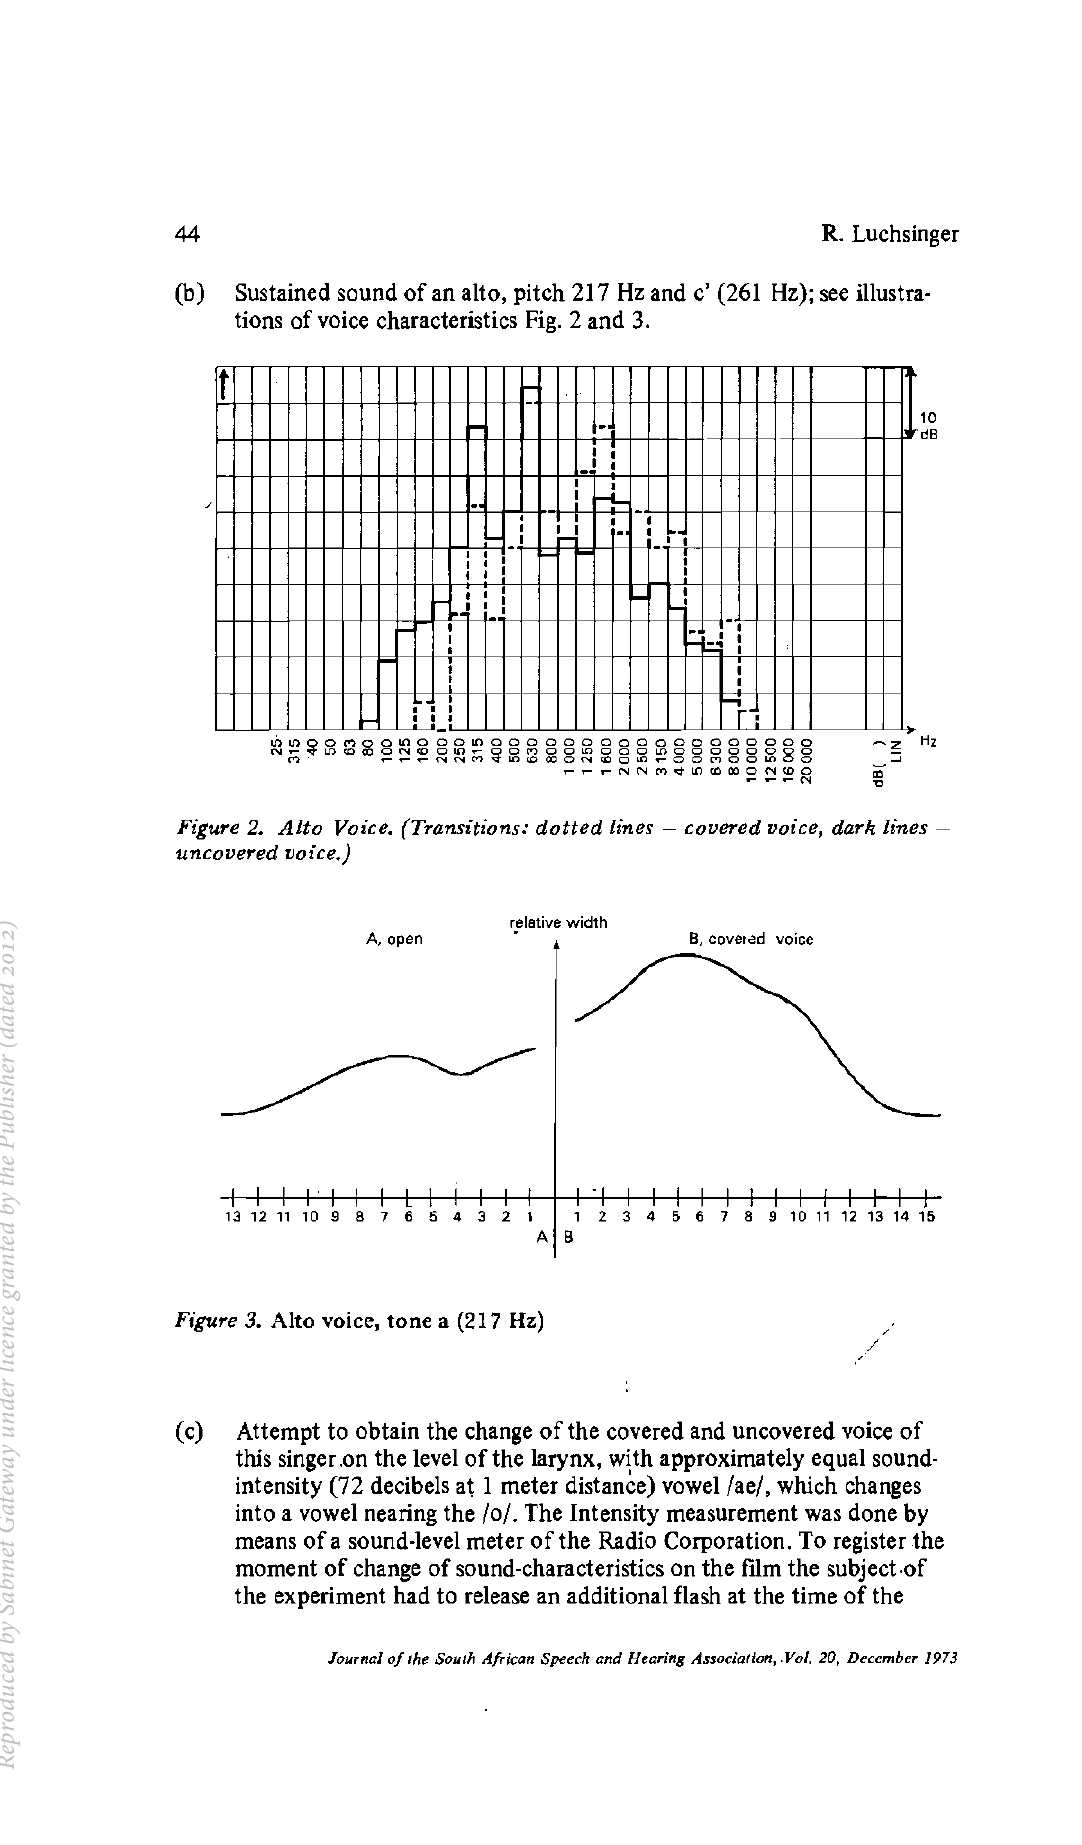
(b) Sustained sound of an alto, pitch 217 Hz and c' (261 Hz); see illustra- tions of voice characteristics Fig. 2 and 3.